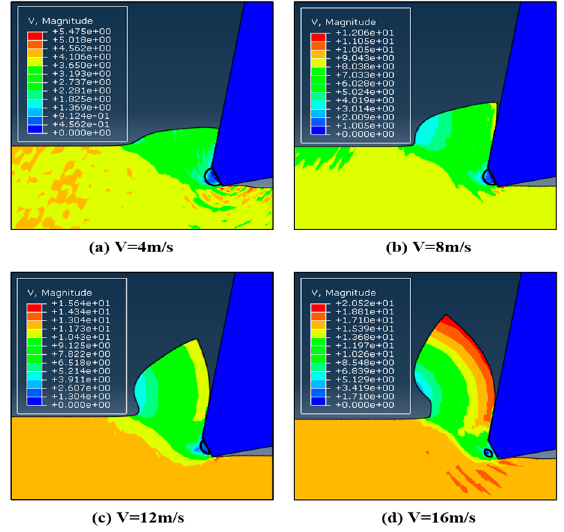
Figure 8. Velocity fi elds of the simulations with the − 25° chamfered tool.